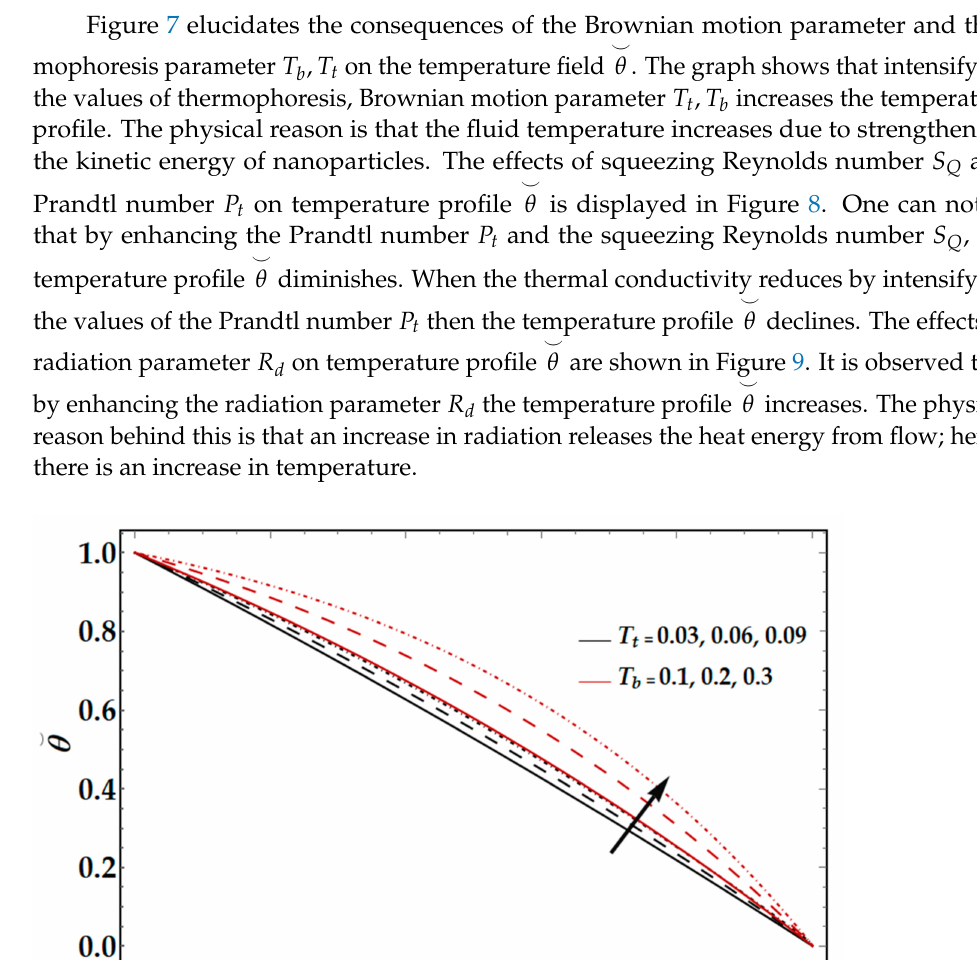
Figure 7. Implications of T t and T b on temperature function